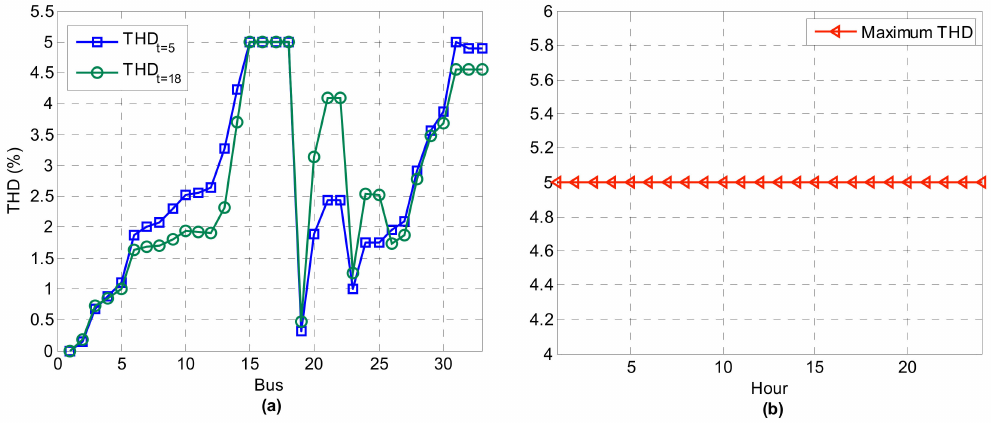
Figure 11. Case III. ( a ) Voltage THD for all buses at t = 5 and t = 18 and ( b ) maximum voltage THD of all buses at each hour.